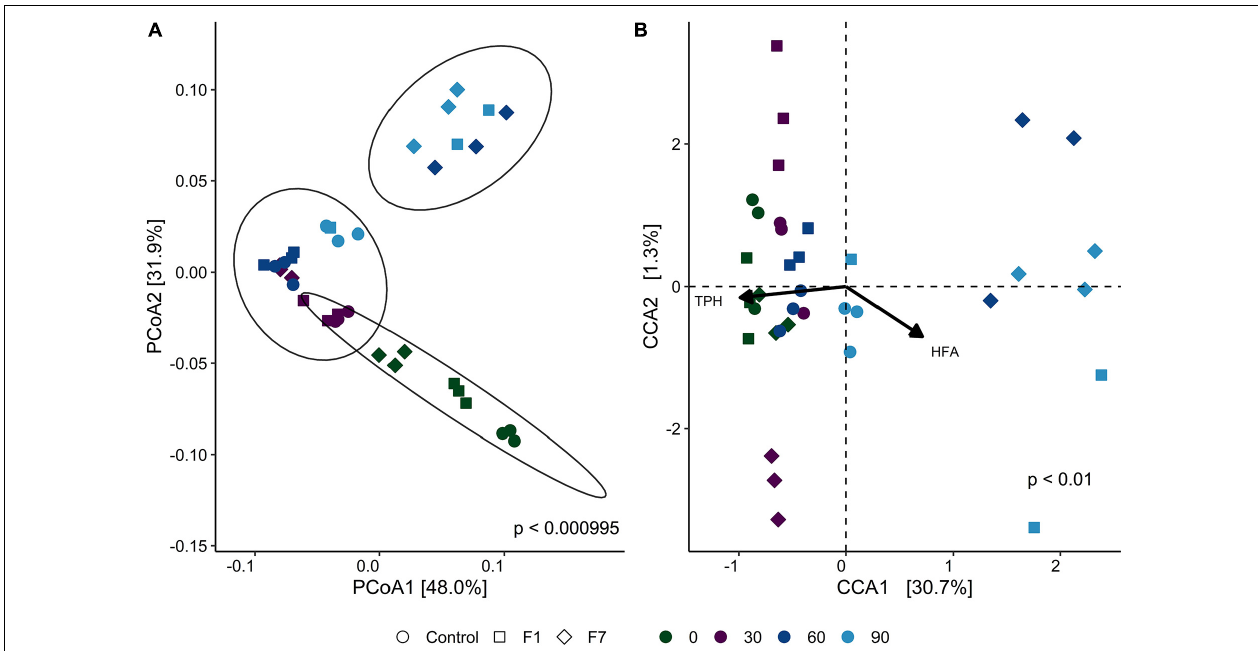
FIGURE 3 | (A) Principal component analysis (PCoA) of bacterial communities, based on weighted UniFrac distance for each sample triplicate. Point shapes represent treatment category, while color indicates time category. The percentage reported on axes represent the amount of total variance depicted by each of them. P -value was calculated by ADONIS function (Vegan R package) between weighted UniFrac distances and sample groups, using the Bray–Curtis method with 1,000 repetitions. UPGMA hierarchical clustering was performed on the same distances. Circles enclose sample groups, which share a dendrogram height = 0.20. (B) Canonical correspondence analysis (CCA) biplot that shows correlation between amplicon sequence variant (ASV) composition of each sample triplicate and the environmental parameters total petroleum hydrocarbon concentration (TPH) and humic and fulvic acid concentration (HFA). Point shapes represent treatment category, while color indicate time category. Black arrows are the eigen-vectors representing constraining variables. Eigen-values of constrained axes are 0.16211 for CCA1 and 0.00856 for CCA2. Of the total inertia, 32% is explained by CCA1 and CCA2 axes. Reported p -value is calculated by PERMANOVA test performed on full model ASV − TPH + HFA with 999